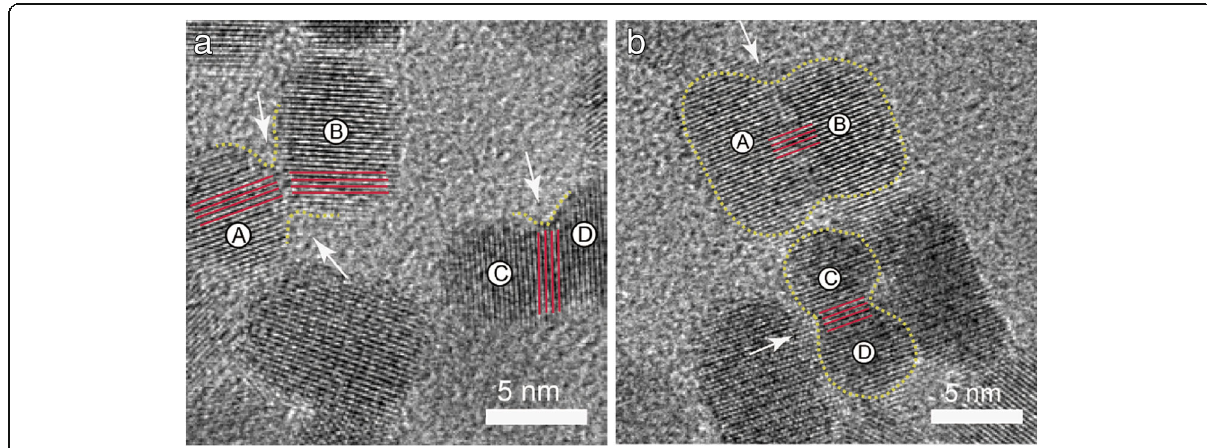
Fig. 4 HRTEM images of ZnO NPs. a Dislocations resulted from the oriented attachment (OA) process. b Nanoparticles formed layer-by-layer either parallel or perpendicular to the c -axis of